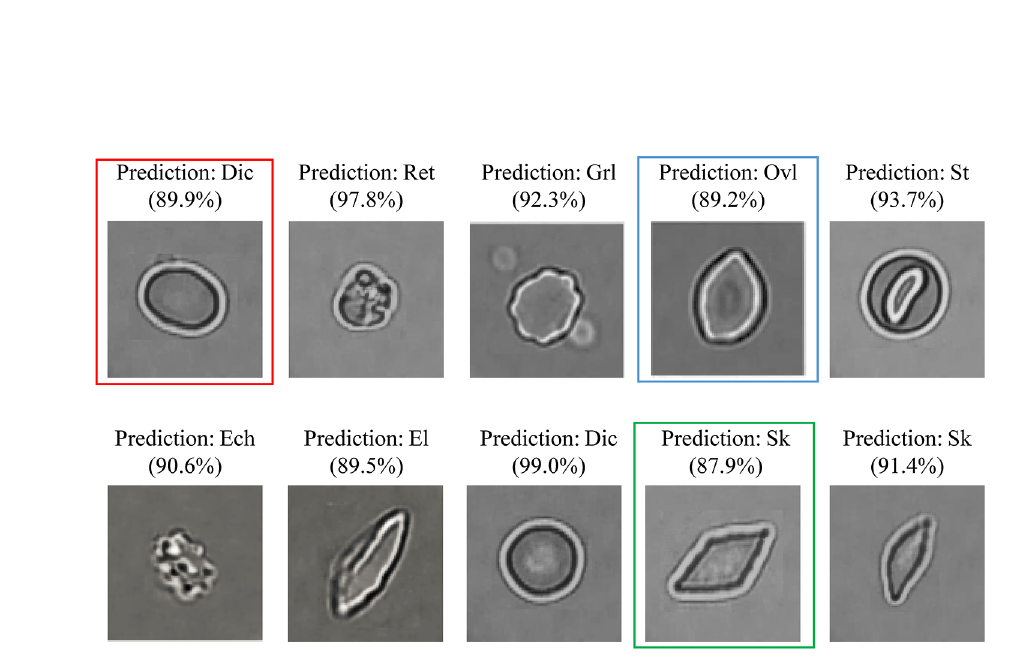
Fig 16. Prediction result example for 8 types of